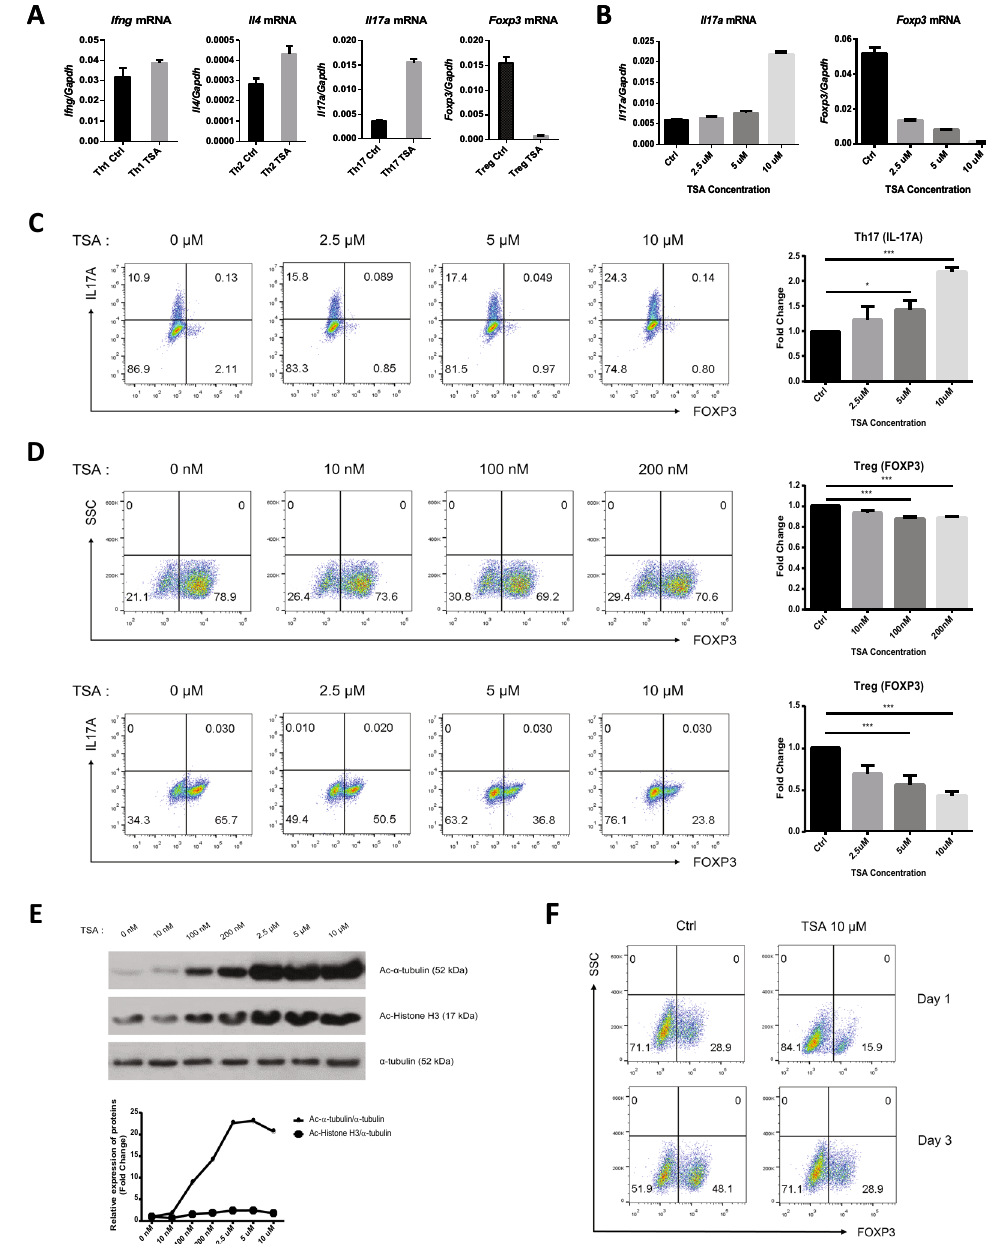
Figure 2. An HDAC6 inhibitor reduces Treg differentiation and maintenance. ( A ) Naïve CD4 + T cells were differentiated for 3 days into each CD4 + T cell subset in the presence of vehicle (control) or TSA (10 µM). Relative expression of Ifng mRNA by Th1 cells, Il4 mRNA by Th2 cells, Il17a mRNA by Th17 cells, and Foxp3 mRNA by Treg cells was measured by qRT-PCR. ( B – D ) Naïve CD4 + T cells were differentiated for 3 days into Th17 or Treg subsets in the presence of various concentrations of TSA. Relative expression of Il17a mRNA by Th17 cells, and Foxp3 mRNA by Treg cells, was measured by qRT-PCR (B). The percentage of IL-17A + cells under Th17-polarizing conditions was analyzed by flow cytometry ( C ), and the percentage of FOXP3 + cells was analyzed under Treg-polarizing conditions ( D ). ( E ) Dose-dependent treatment of TSA increased the level of acetylated (Ac) α-tubulin. Protein levels of Ac-α-tubulin and Ac-Histone H3 were detected by immunoblot analysis (top) and relative expression of each protein was quantified using ImageJ software (below). ( F ) CD4 + CD25 + (tTreg) cells were isolated from mouse spleens and cultured for 1 or 3 days with vehicle (control) or TSA (10 µM). The percentage of FOXP3 + cells was analyzed by flow cytometry. qRT-PCR and dot plot data are representative of three independent experiments. Statistical analysis in C and D was performed using data pooled from three individual experiments. Error bars represent the SD, and P values were determined by the Student’s t test. * P < 0.05; ** P < 0.01; *** P < 0.001; and **** P < 0.0001, n.s., not